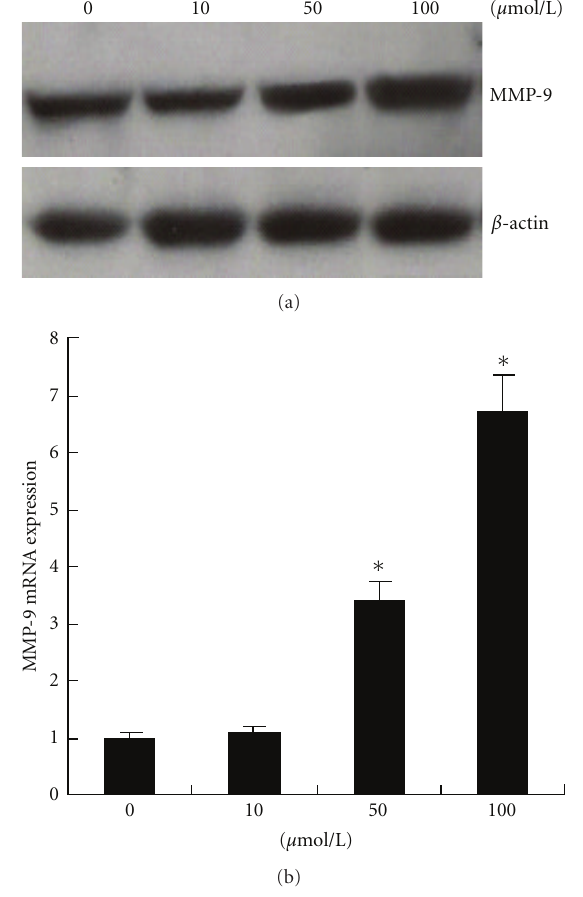
Figure 6: Upregulation of MMP-9 by exogenous PGE 2 Western blotting (a) and real-time PCR (b) revealed MMP-9 was upregu- lated in BxPC-3 cells treated with 50 μ mol/L ( ∗ P < 0 . 01, versus 0 μ mol/L) or 100 μ mol/L ( ∗ P < 0 . 01, versus 0 μ mol/L). Data are expressed as mean ± SD, n = 3.